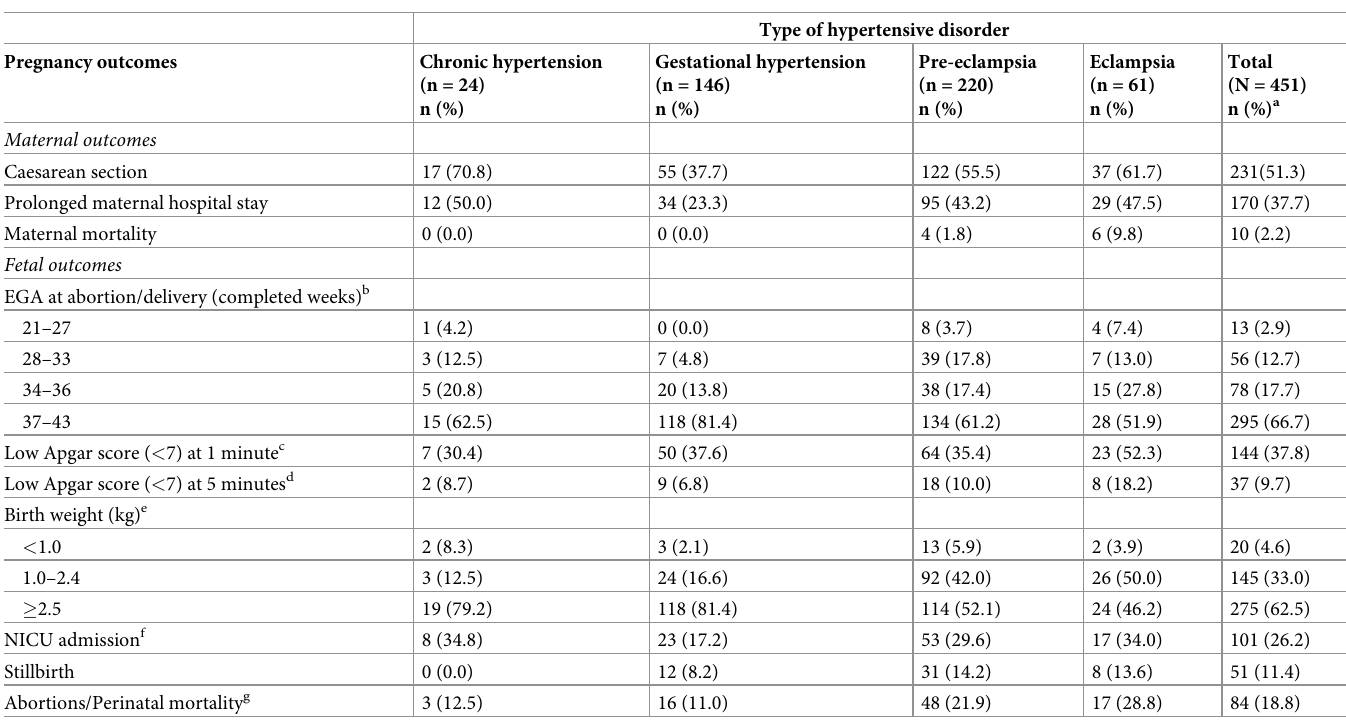
Table 2. Adverse maternal and fetal